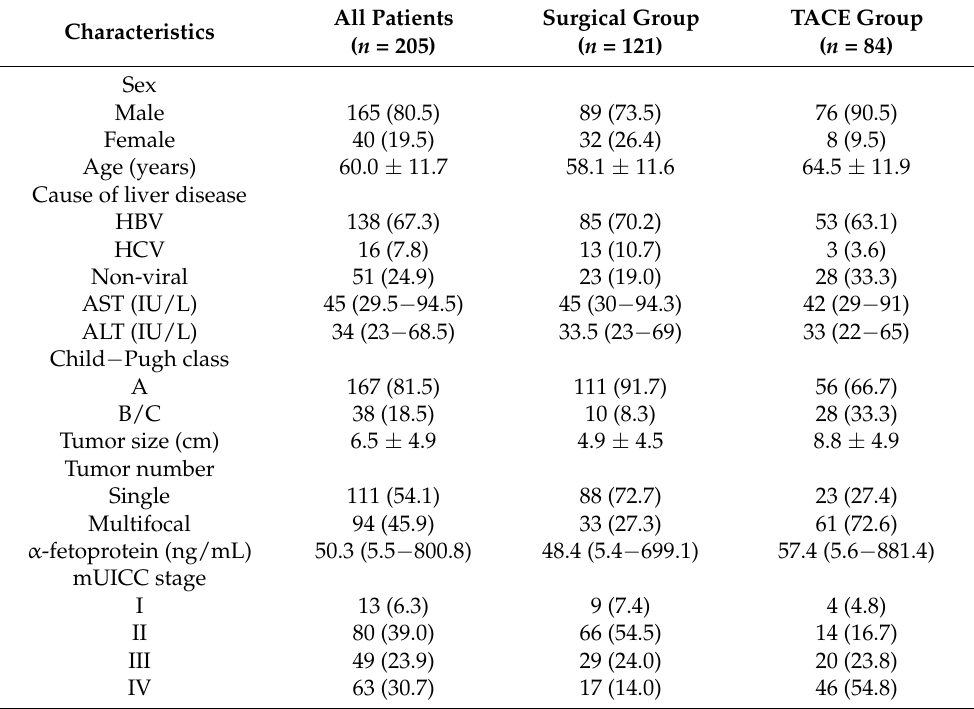
Table 1. Baseline characteristics of the study population.